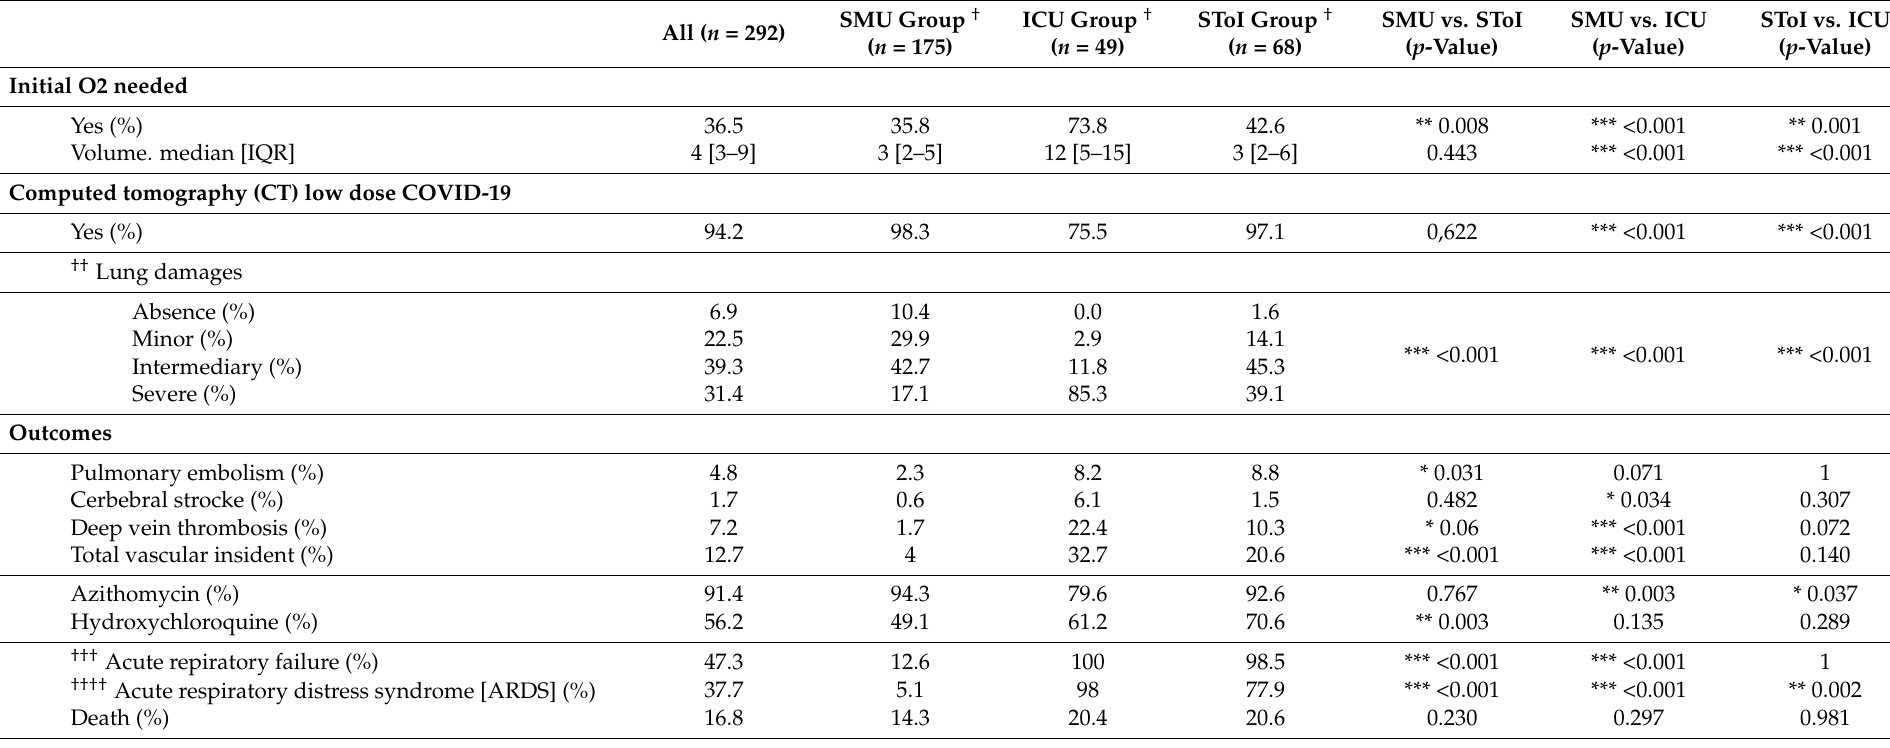
Table 2. Population’s characteristics (demographic data, important timelines, initial vital sign, income data, comorbidities, outcome data); comparison between groups for training cohort. Parameters with a p -value < 0.05 have significative differences between groups compared. ††† Acute respiratory failure (ARF) was defined as Respiratory rate > 20 (or accessory muscle use for ventilation), and hypoxemia (PaO 2 less than 60 mm Hg on breathing room air). †††† Acute respiratory distress syndrome (ARDS): Acute respiratory failure not explained by cardiac failure or fluid overload with bilateral lung opacities on chest imaging and PaO 2 /FiO 2 < 300 with positive end-expiratory pressure > 5 cm H 2 O. †† Radiological lung damage severity was defined as Minor when patients had 3 compromised sites, with 3 lobules affected on each site (maximum 9 lobules), Intermediary, when patients had a minimum of 10 lobules affected, but less than 50% of total segmental volume, and Severe, when more than 50% of total segmental volume was affected. † SMU group: patients only admitted to Standard Medical Unit, ICU group: patients directly admitted to Intensive Care Unit, SToI group: patients transfered from Standard medical unit to Intensive care unit. * p < 0.05; ** p < 0.01; *** p <